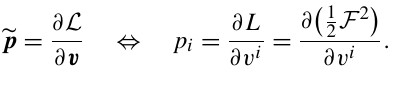
Figure 5. Huygens’ principle visualized as the coalescence of ero- sional wavelets (green curves, for η = 3 envelope (pale grey